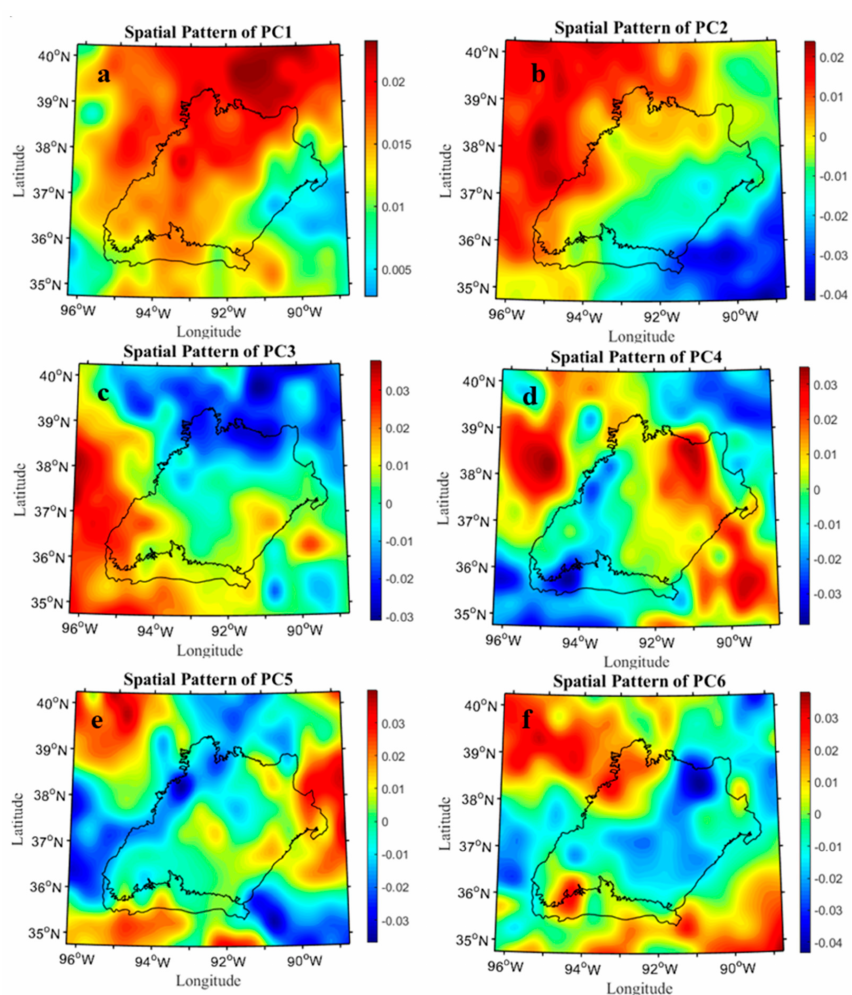
Figure A1. The spatial patterns of the first six PCs estimated from the original monthly scPDSI from 2000 to 2015. Red represents a relatively high correlation while blue means a relatively low correlation ( a – f